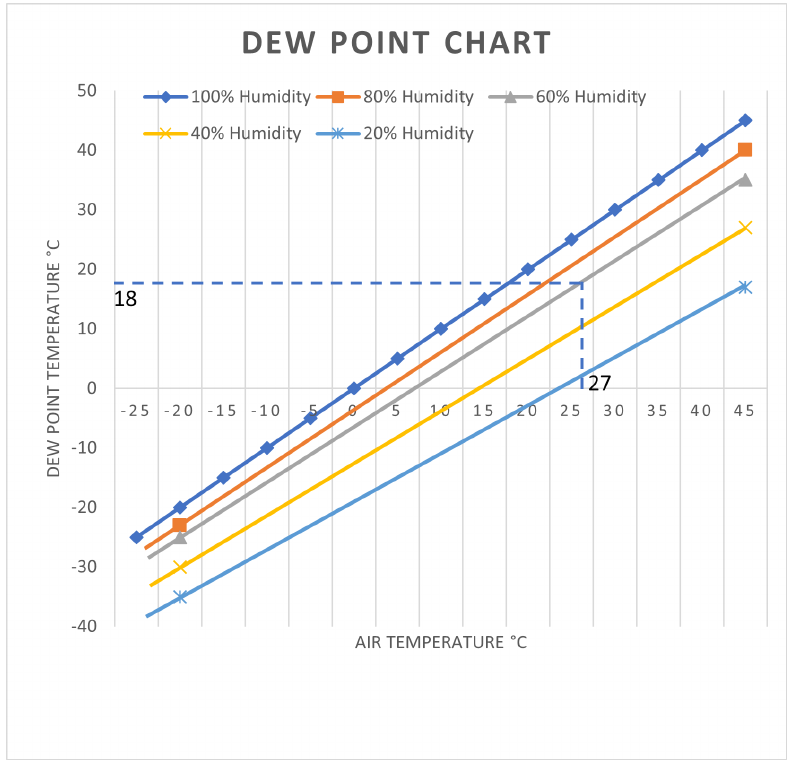
Figure 1. The relationship between the air temperature, the dew point, and the humidity (adapted from